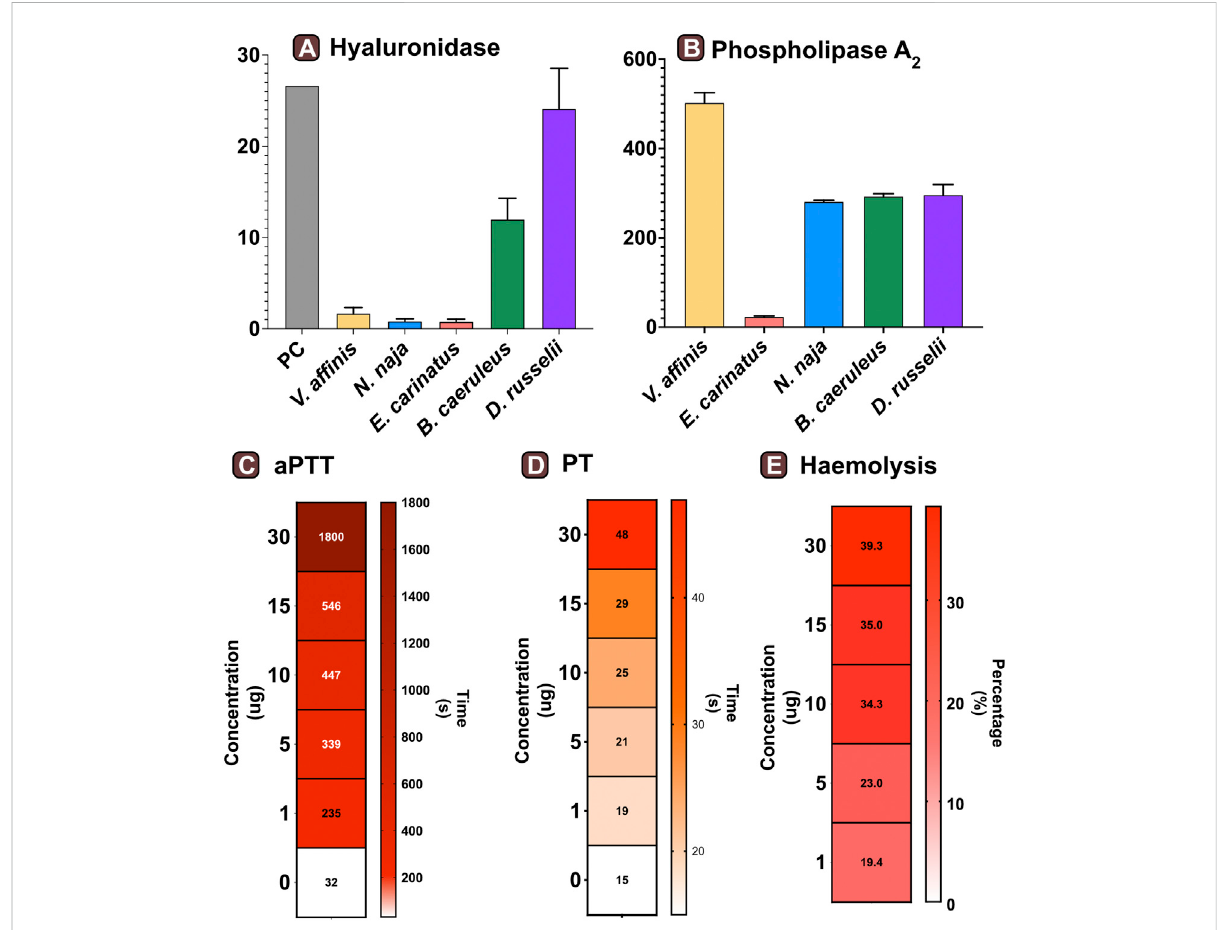
FIGURE 3 Functional pro fi le of Vespa venom. Graphs in panels (A) and (B) represent the hyaluronidase (TRU · mg − 1 · min − 1 ) and phospholipase (nmol · ng − 1 · min − 1 ) activity of V. af fi nis venom in comparison to the venoms of the “ big four ” Indian snakes. Here, the error bars represent the standard deviation, and PC denotes the positive control. Heatmaps depict the anomalies caused by wasp venom on the blood coagulation cascade via (C) intrinsic and (D) extrinsic pathways. The colour scales in these panels represent the time in seconds, while the time required to form the fi rst fi brin clot is denoted within each cell. Panel (E) depicts the haemolytic potential of V. af fi nis venom as a percentage relative activity to the positive control (0.5% Triton X). The numbers within cells show the percentage of